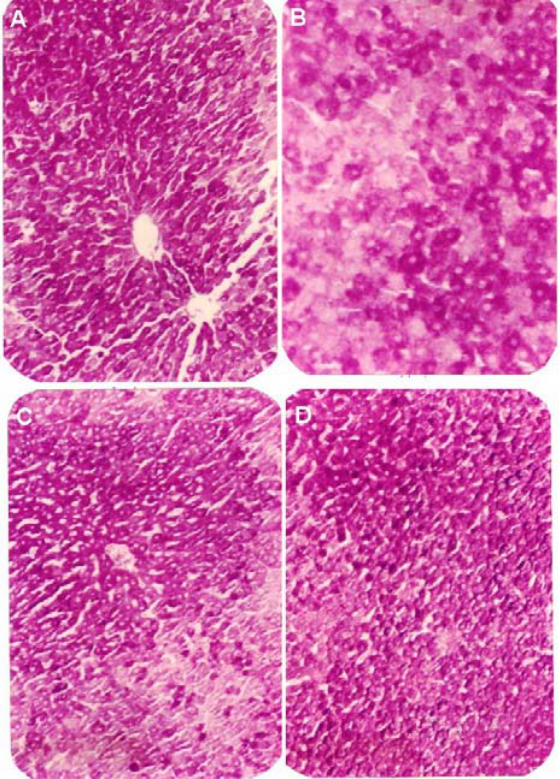
FIGURE 5. Section of liver stained with Periodic acid-Schiff stain showing mucopolysaccharide materials in the cytoplasm of hepatocytes: (A) control (normal) rat; (B) CCl 4 -treated rat showing marked diminution of mucopolysaccharides in the cytoplasm of some hepatocytes; (C) CCl 4 + DDB (375 mg/kg)-treated rat showing increase in mucopolysaccharide content; (D) CCl 4 + DDB (75 mg/kg) + silymarin (22 mg/kg)-treated rat showing mucopolysaccharide contents more or less normal (Periodic acid-Schiff reaction x